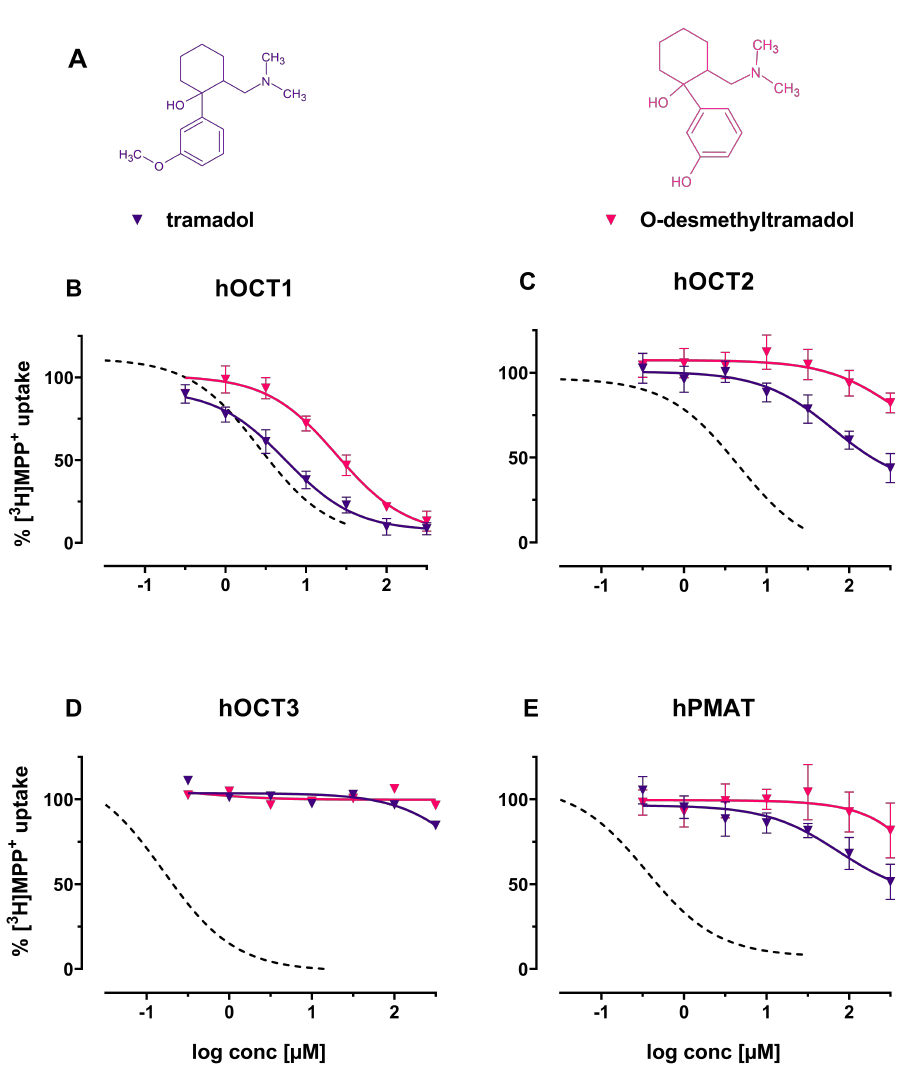
Figure 6. ( A ) Chemical structures of the herein investigated analgesics tramadol (violet) and O - desmethyltramadol (red); ( B – E ): Effects of the above-mentioned compounds (including decynium-22; dashed line) on ( B ) hOCT1, ( C ) hOCT2, ( D ) hOCT3 and ( E ) hPMAT of uptake of tritiated MPP + in HEK293 cells stably expressing the respective